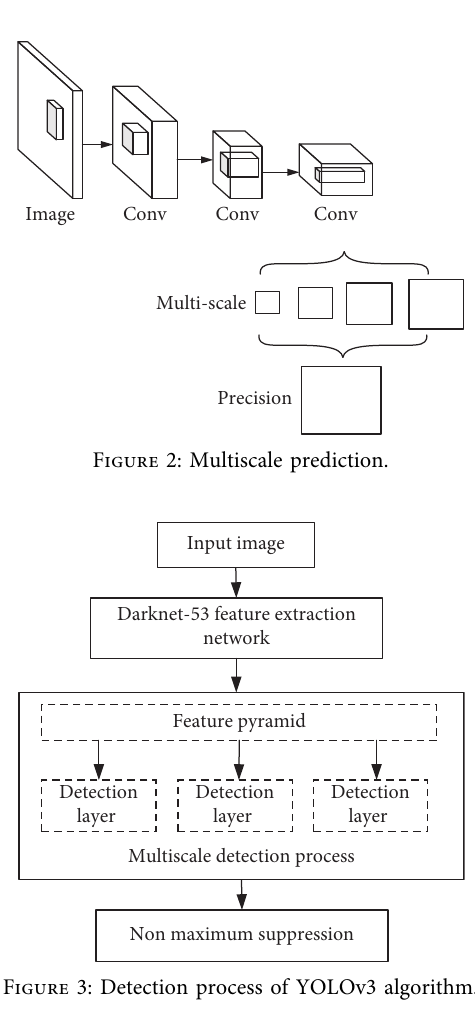
Figure 3: Detection process of YOLOv3